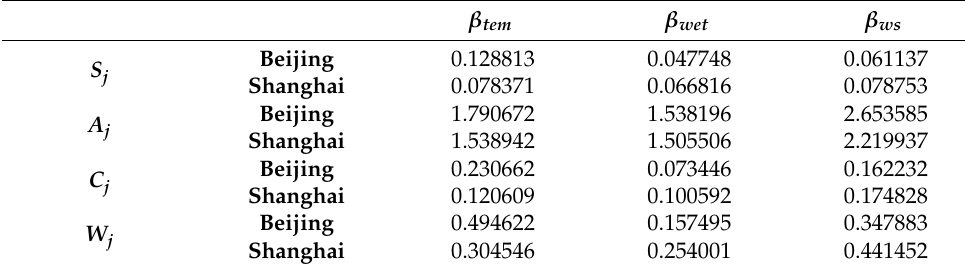
Table 3. Calculation results of Beijing β